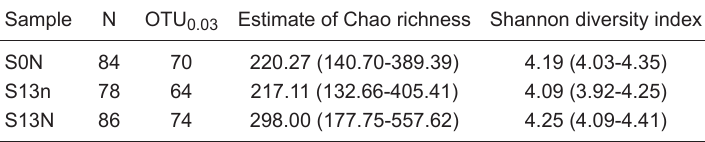
Table 5. Chao and Shannon indexes for 16S rRNA gene sequence libraries.